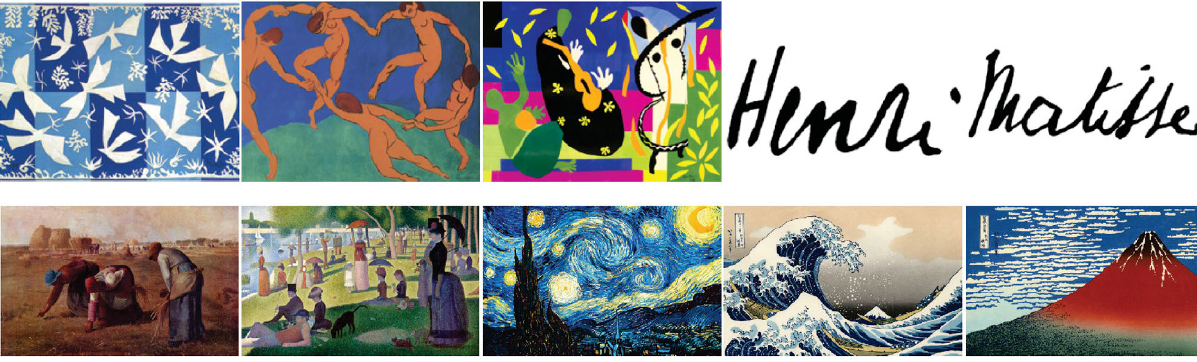
, and secret I S . 1 2